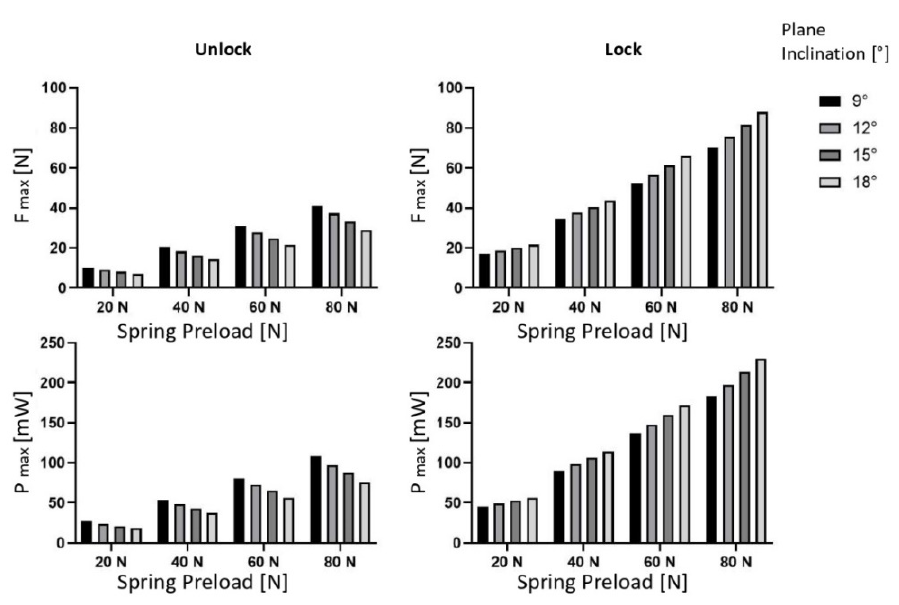
Figure 7. Main results of multibody model (friction coefficient: 0.15, spring stiffness: 20 N/mm).